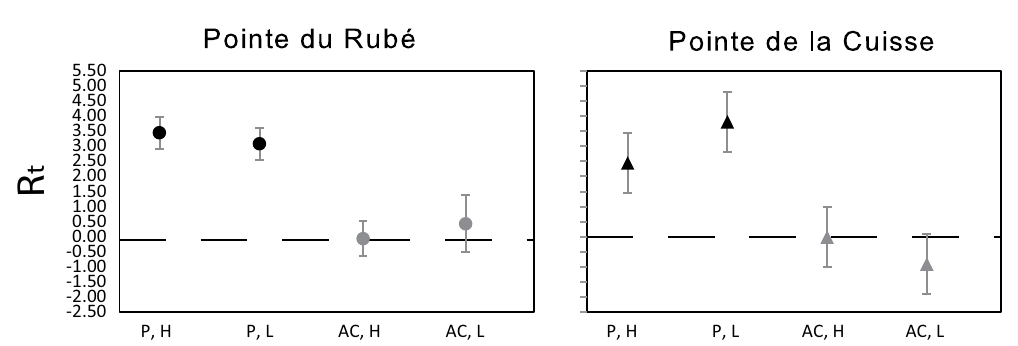
Figure 8. Fertility. Number of receptacles/12.5 cm 2 (mean plus SE calculated on all plots, n = 4) for each zone and treatment in June. P: protected; C: control plots; AC: artefact control. Letters above the bars indicate significant differences of the pairwise-tests on the interaction TrxZo (see Table 1 and Supplementary Tables S4.1–2).